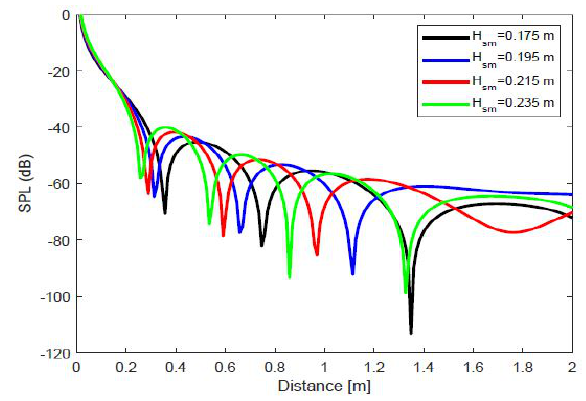
Figure 5. Evolution of the sound pressure level in dB of the SMP.